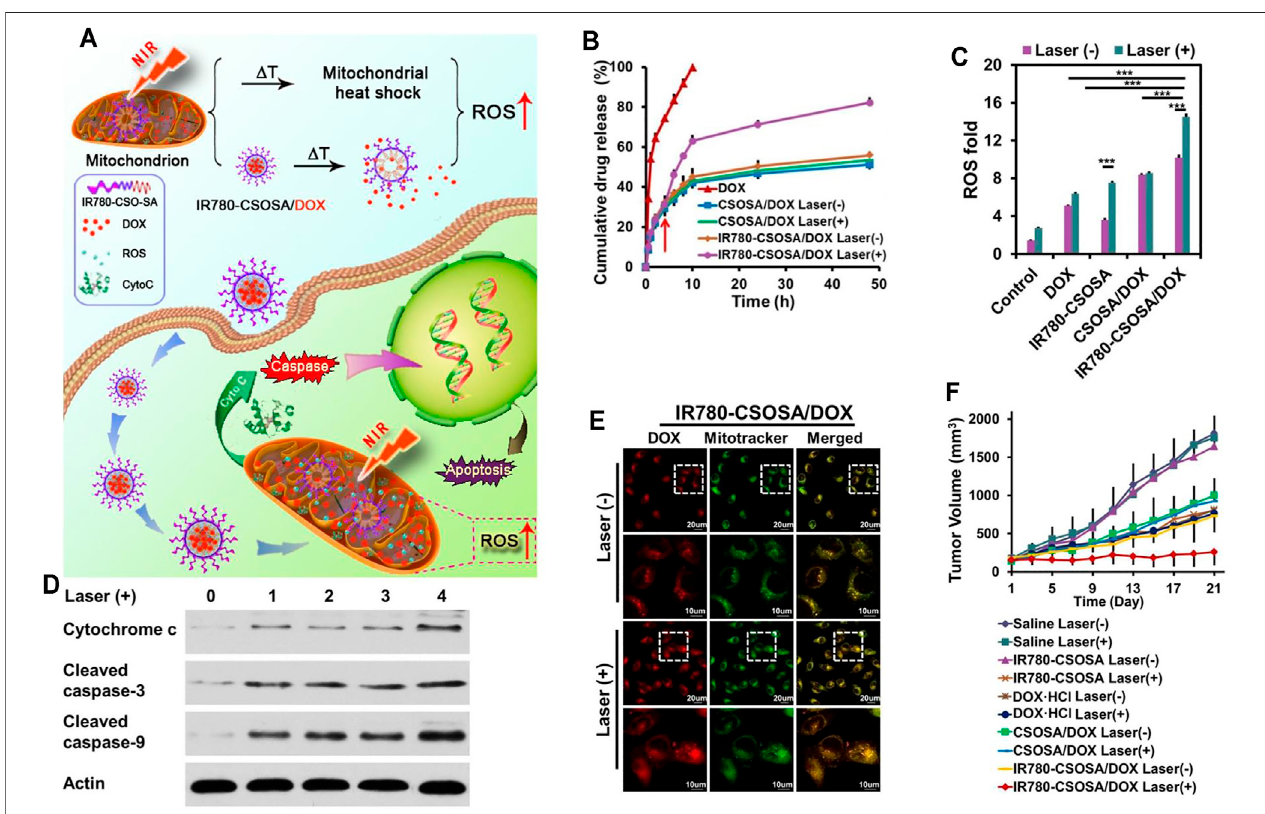
FIGURE 5 | (A) The NIR-triggered DDS with mitochondria-sensitive drug release and heat shock capabilities. Under NIR, IR780-CSOSA/DOX nanomicelles selectively targeted mitochondria and achieved photothermal conversion, which photothermally triggered DOX release and heat shock in mitochondria, leading to a cascadingeffectonROSbursttoachieveampli fi edtherapeuticef fi cacy. (B) NIR-triggeredDOXreleaseinPBS(pH6.8). (C) ROSlevelsinMCF-7. (D) Levelsofapoptosis proteins in MCF-7. 0: control, 1: DOX, 2: CSOSA/DOX, 3: IR780-CSOSA, 4: IR780-CSOSA/DOX. (E) DOX release into the mitochondria in MCF-7. (F) Tumor growth curves after administration (Tan et al.,